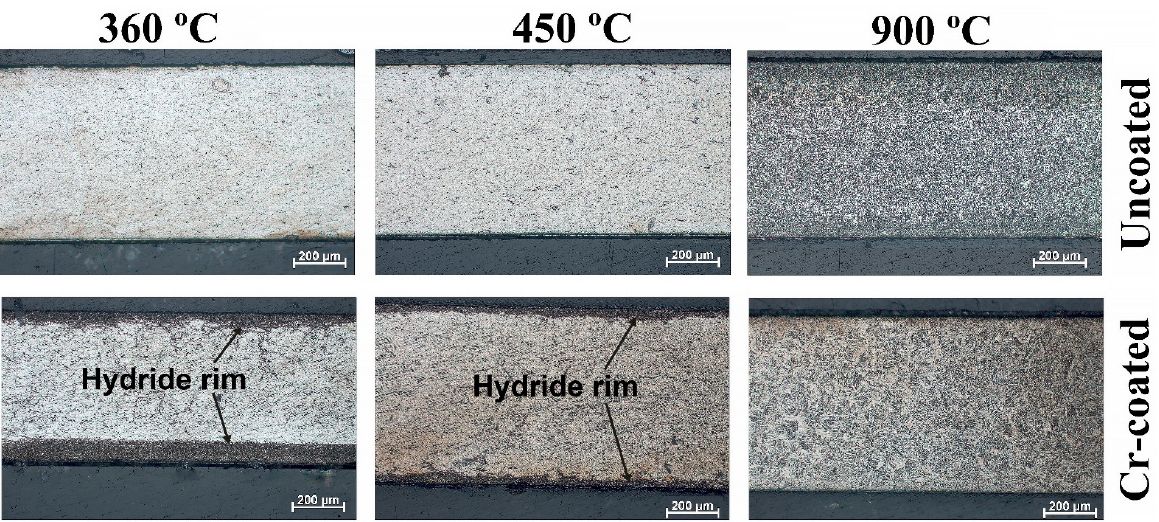
Figure 5. Cross-section optical images of uncoated and Cr-coated RUW E110 alloy specimens in tube zones. Table 2. Hardness of uncoated and Cr-coated RUW E110 alloy